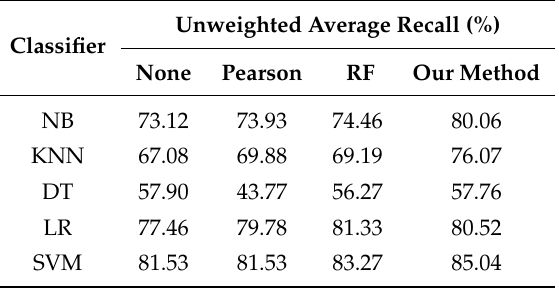
Table 9. Unweighted average recall of speaker-dependent speech emotion recognition on Emo-DB.